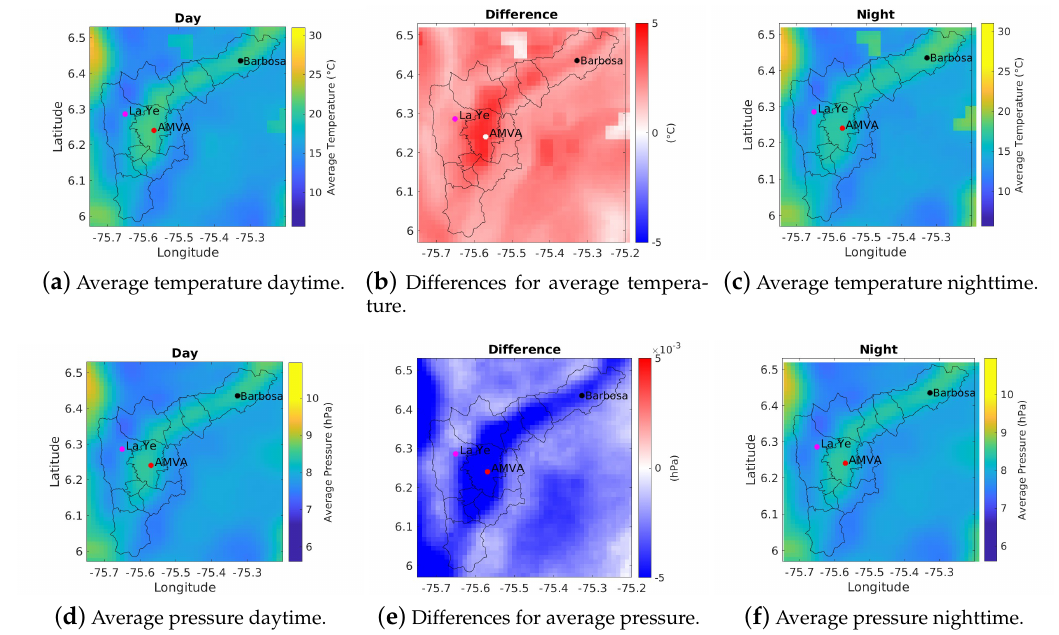
Figure 4. Average temperature and pressure in the Aburrá Valley for the undisturbed run for daytime and nighttime. ( a ) Average temperature during daytime. ( b ) Differences between daytime and night- time temperature average. ( c ) Average temperature during nighttime. ( d ) Average pressure during daytime. ( e ) Differences between daytime pressure and nighttime pressure average. ( f ) Average pressure during